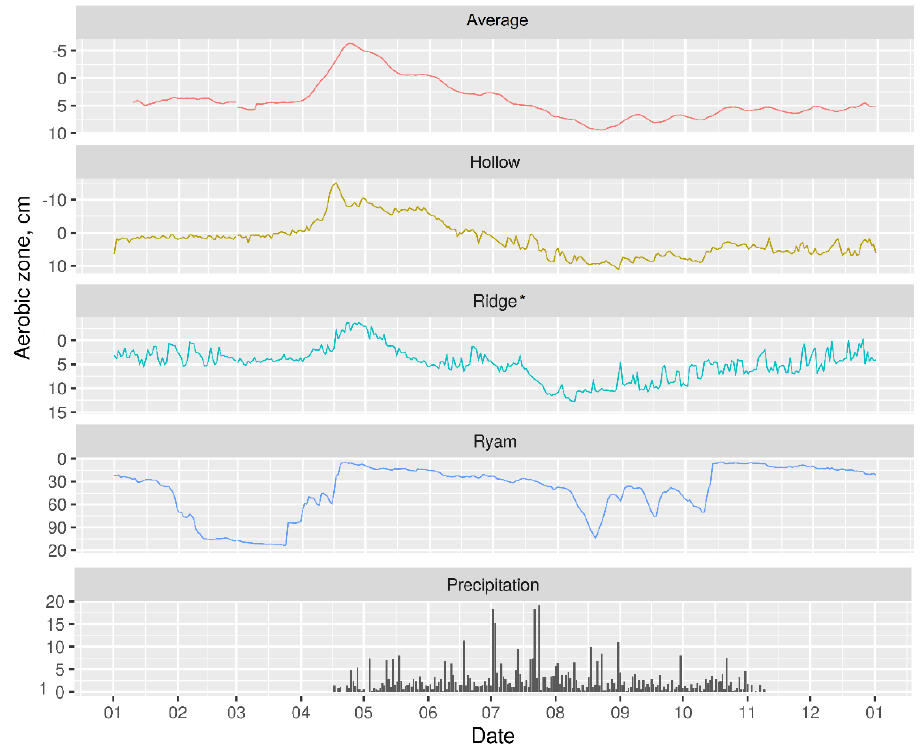
Figure 5. Averaged annual water table depth variation for different microtopes, cm. Positive y-values represent water above the surface, negative y-values represent water below the surface. Grey bars represent precipitation in mm. * A piezometer on the ridge was installed in a local depression − 25 cm deep.